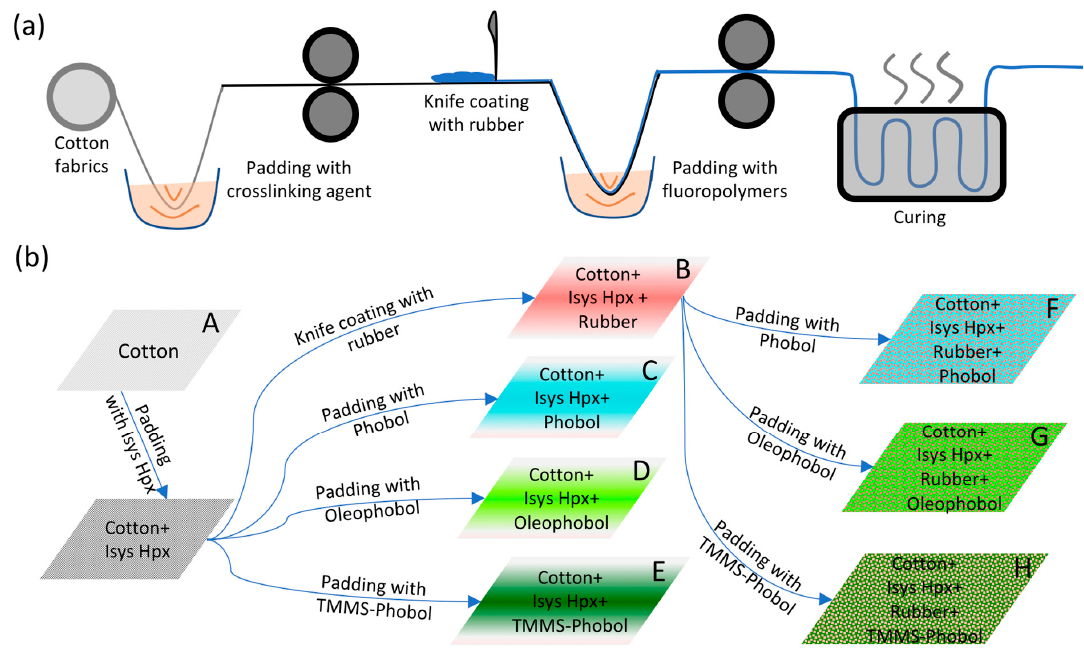
Figure 1. Schematics of the pad-knife-pad-cure method ( a ) and the experimental design ( b